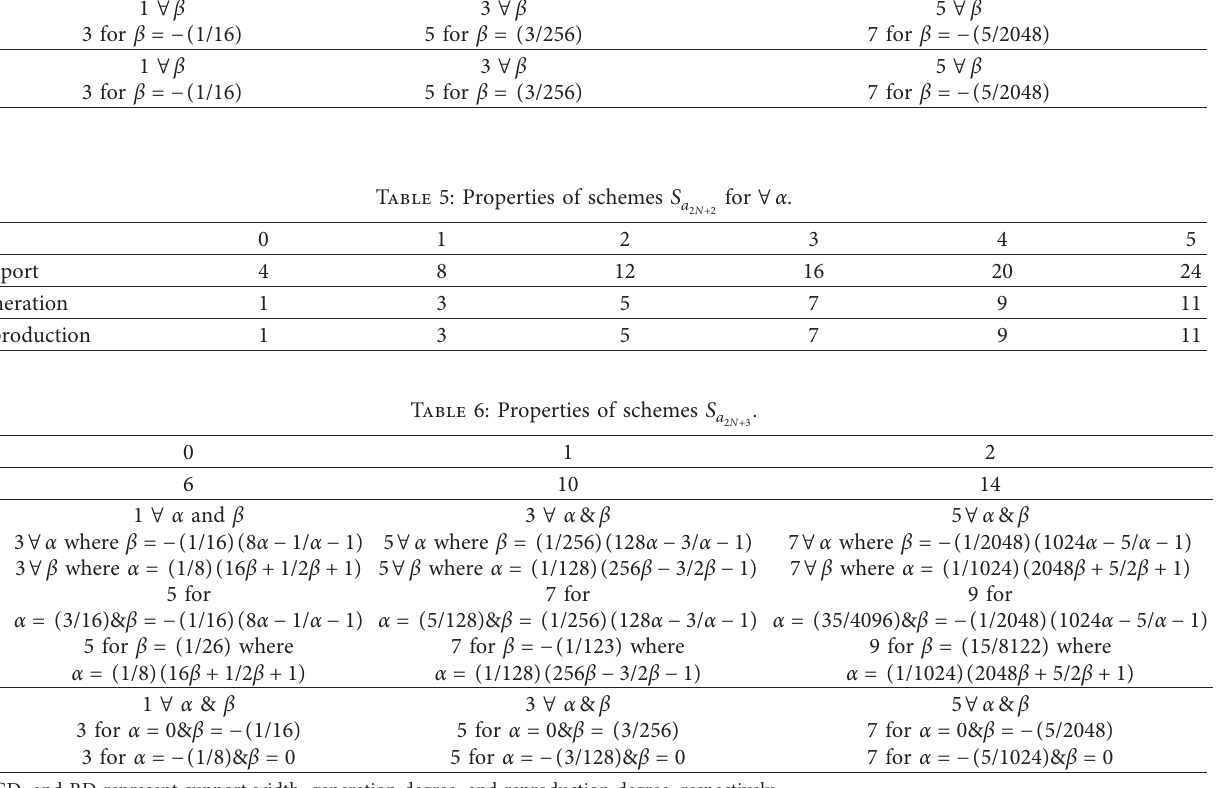
Table 5: Properties of schemes S